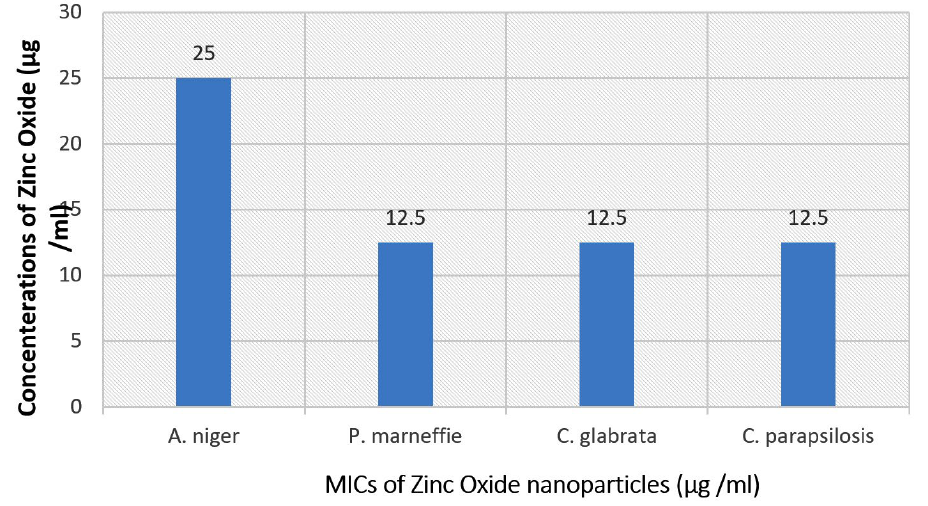
Fig. 15. Minimum inhibitory concentration (MIC) histogram against the pathogenic fungal